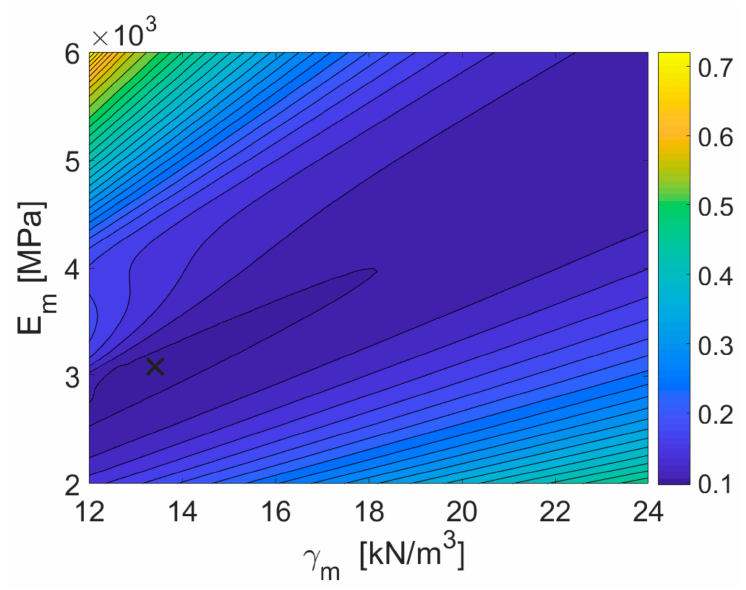
Figure 12. Contour plot of the objective function C in the range of variation of parameters E m and γ m , at the identified value of E b .